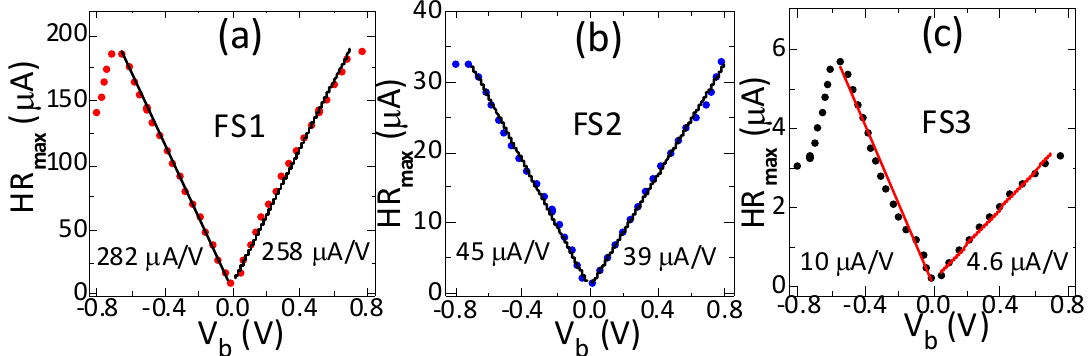
Figure 4. Effect of bias voltage on hysteresis (HR max ) of sensors with high (a), medium (b) and low (c) sensitivity. The hysteresis considerably changed with bias magnitude and polarity and was lower under positive negative polarity. The linear ranges of the hysteresis were determined by fitting the linear model to the measured data using the least squares method. Solid lines represent the linear fits and the dotted lines are the experimental results.